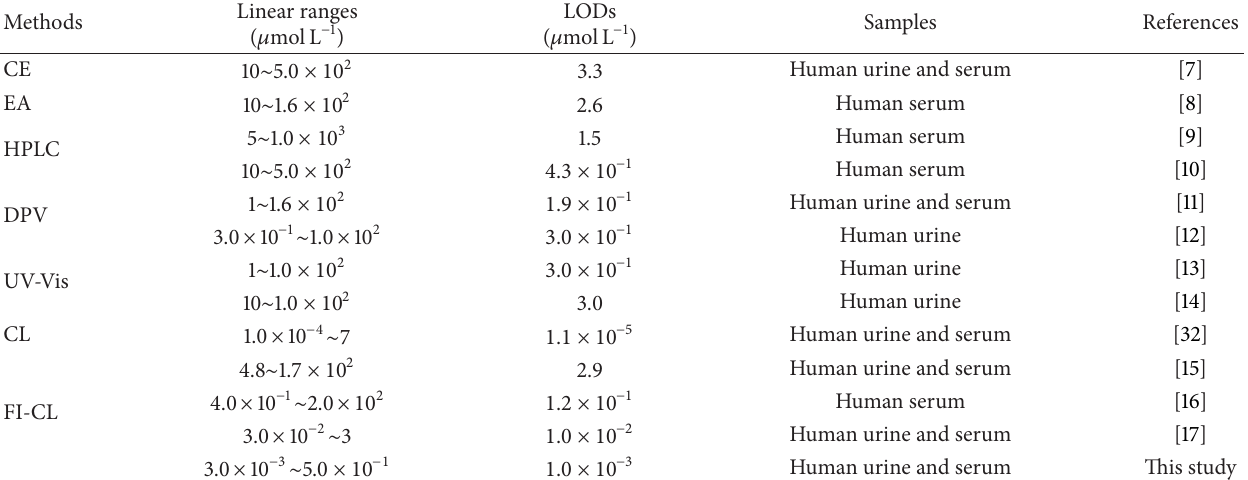
Table 4: Comparison of different methods for UA